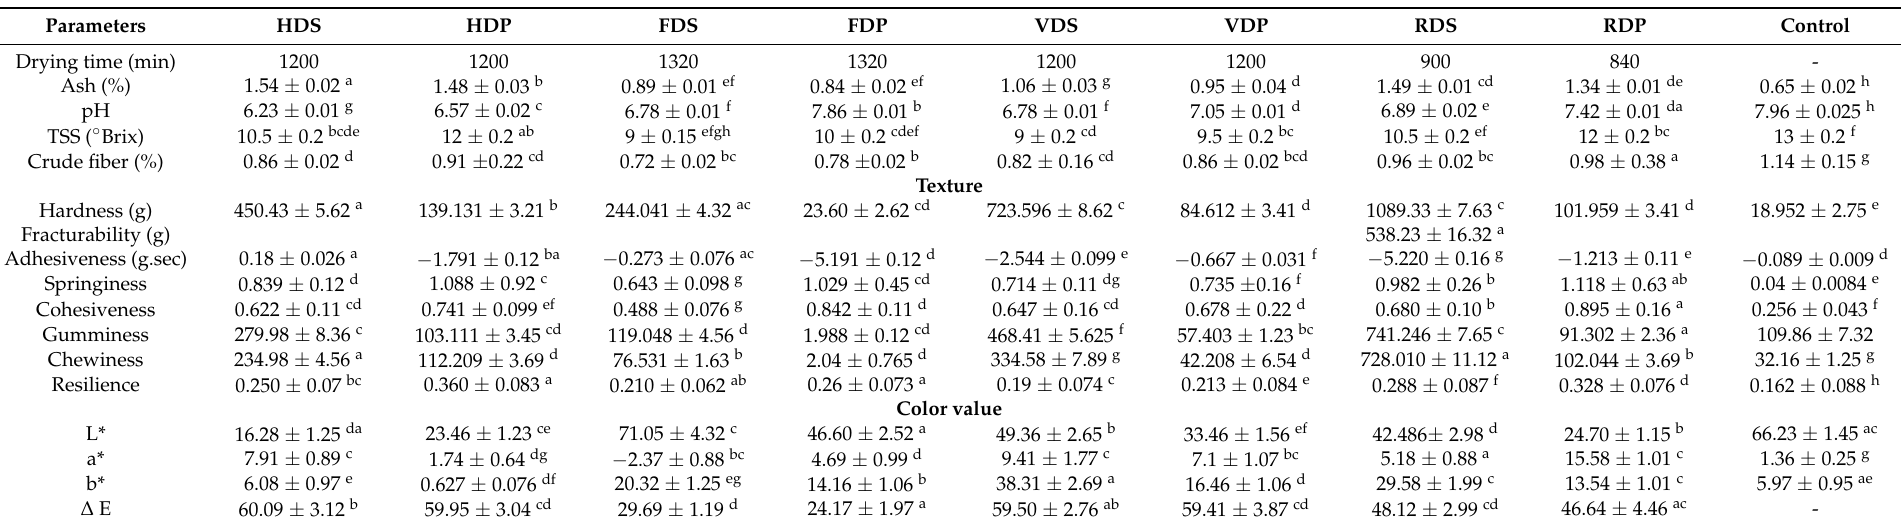
Table 1. Physicochemical, drying time, and quality attributes of dragon fruit samples 1